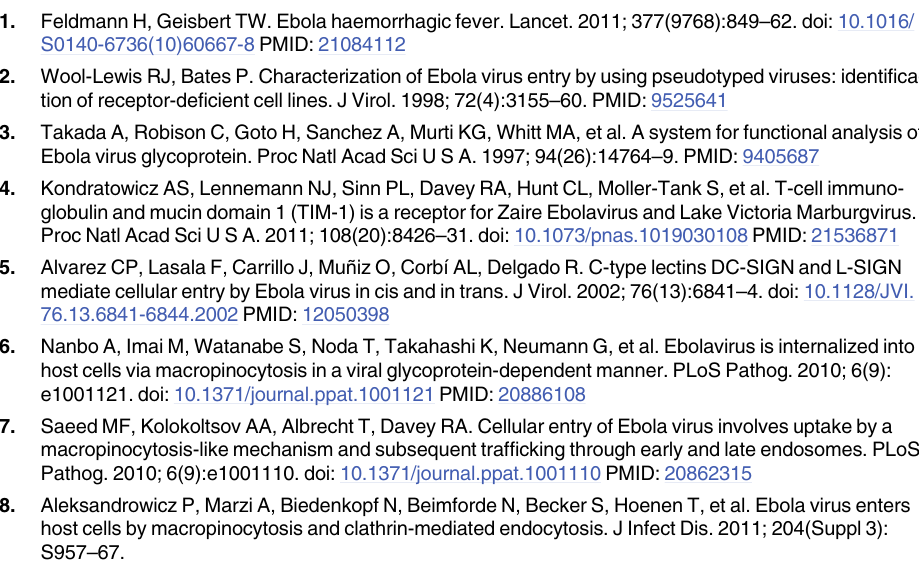
S5 Fig. Attachment, uptake, and localization of DiI-labeled SUDV VLPs. Untreated (Con- trol), CTR IgG-, and ZGP12/1.1-treated DiI-labeled SUDV VLPs were inoculated into K562 cell lines and SUDV VLPs (red) on the cell surface at 0 h (A, D) and VLPs (red) and eGF- P-Rab7 (B, E) (green) or Dx10 (C, F) (green) in the cytoplasm at 2 h after adsorption were monitored by confocal laser scanning microscopy. Scale bars represent 10 μm. Nuclei of cells are visualized with DAPI (blue). The number of SUDV VLPs on the cell surface (D) and the colocalization of SUDV VLPs (DiI) and eGFP-Rab7 (E) or Dx10 (F) signals were quantified. The mean and standard deviation of three independent experiments are shown. Statistical analysis was performed using Student’s t -test ( (cid:3) p <